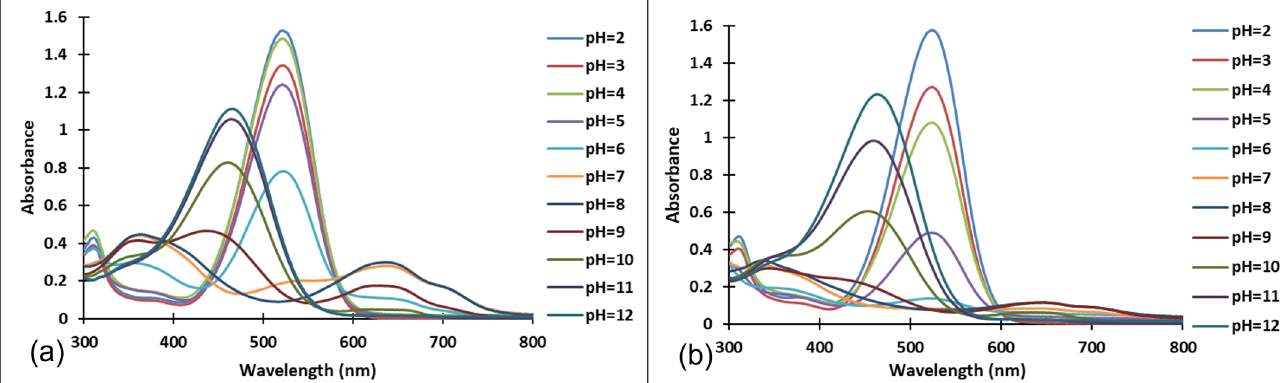
Figure 6. Absorption spectra of the species derived from compound 3 ( a ) at pH 8 in time ( b ) variation in time of the absorption maxima of the quinoidal base A λ = 624 nm and the cis or trans chalcones λ = 345 nm at pH 8. In the pH range 3 to 6, compound 4 is not stable in time and bleaching of the solutions was observed, corresponding to the formation of the hemiketal (B). In the pH range 7 to 9 the predominant species are the quinoidal base (A) and cis and trans chalcones (Cct, Ctt), which are not stable over time. The transformations of species for compound 4 over time are shown in Figure 7. At pH 8, the formation of neutral species Cct, Ctt from the quinoid base (A) was noticed, while at pH 9 the formation of the species (Ctt 2 − ) was observed.